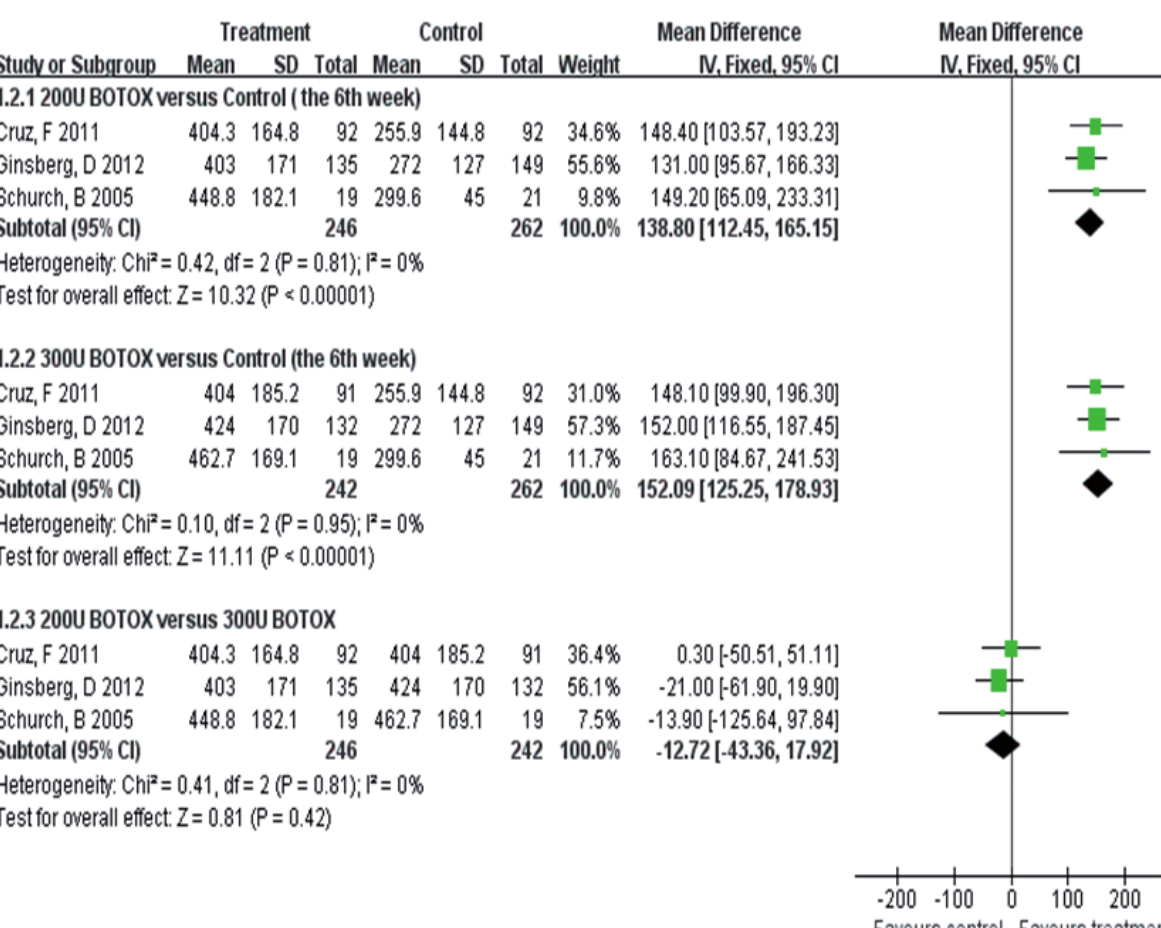
Figure 3 - Forest plot for the outcome of maximum cystometric capacity